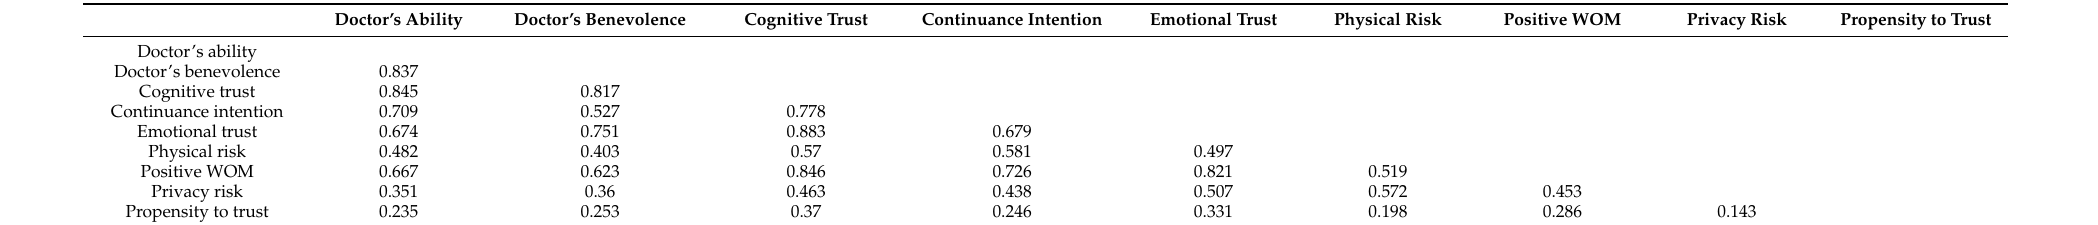
Table 6. Results of discriminant validity (HTMT